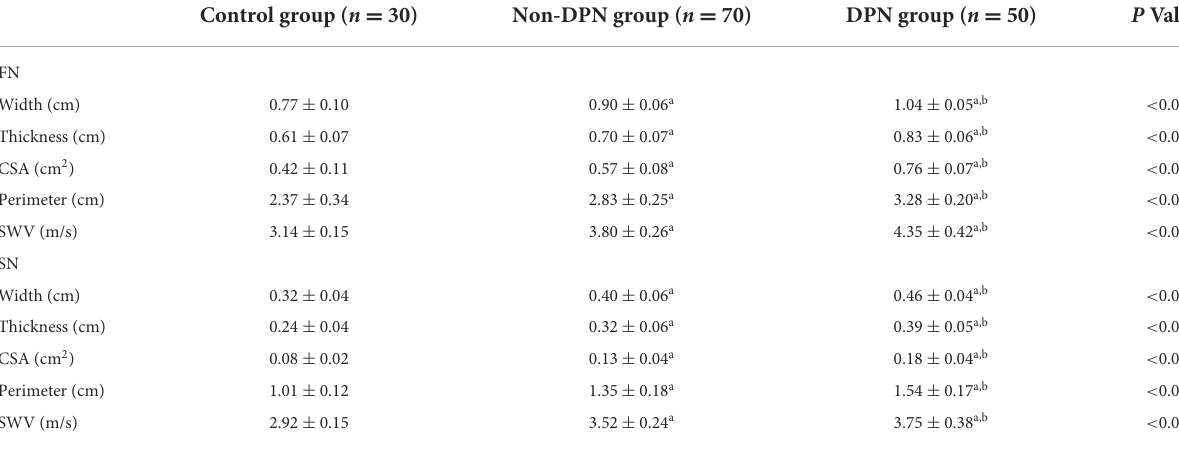
TABLE 2 Comparison of ultrasound parameters of the femoral nerve and saphenous nerve among subjects in three groups.